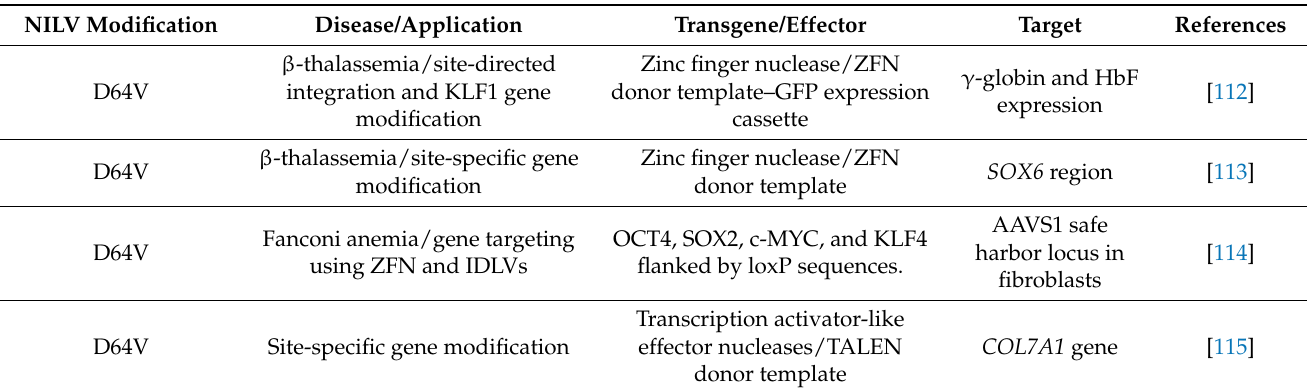
Table 7. A summary of the elements used in developing non-integrating lentiviral vectors (NILVs) for site-directed integration in pre-clinical studies. Different approaches for direct integration or site-specific modifications of safe genomic loci in different studies are listed with attached